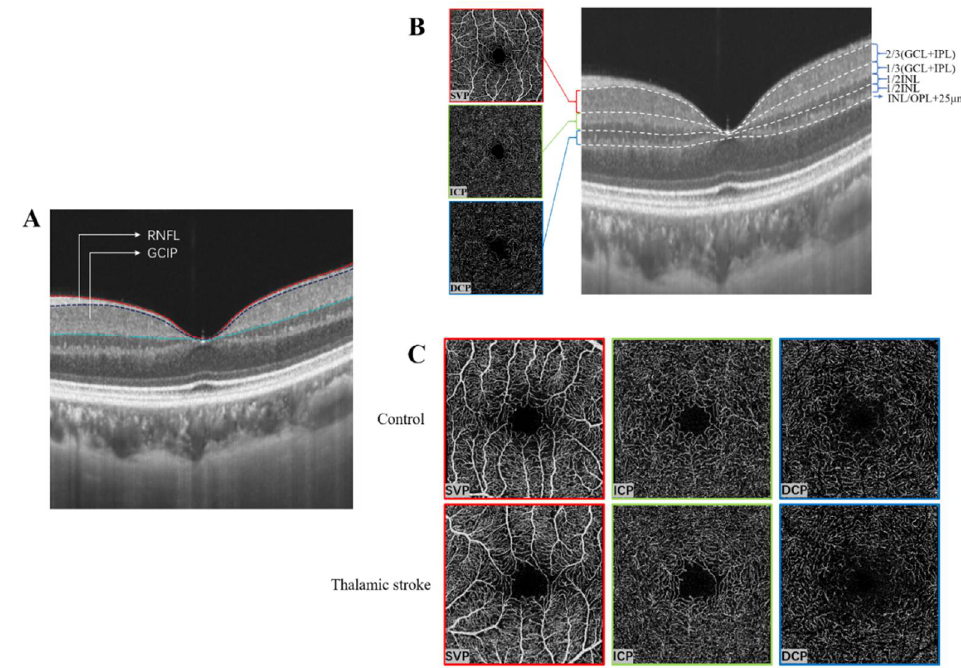
Figure 2. Segmentation of macular structure and microvasculature. ( A ) shows the macular structural segmentation. ( B ) shows the segmentation of the macular microvasculature. The SVP was defined as the microvasculature between the base of the retinal nerve fiber layer (RNFL) to the junction between the inner plexiform layer (IPL) and inner nuclear layer (INL). ICP was defined as the microvasculature between IPL/INL junction to the junction between INL and outer plexiform layer (OPL). DCP was defined as the microvasculature between the INL/OPL junction to 25 µm below the OPL. ( C ) shows the en face OCTA images between thalamic stroke patients and healthy controls.